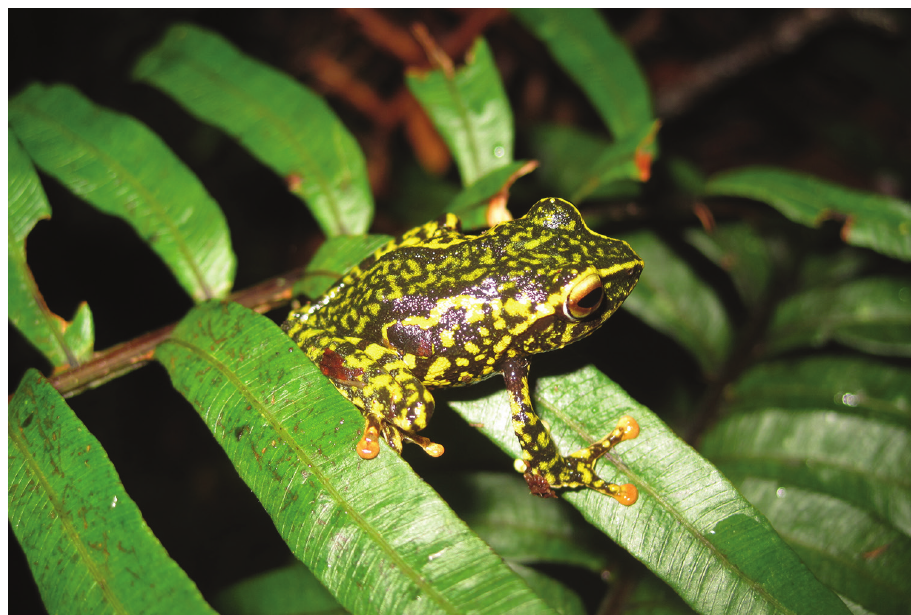
Figure 30. Philautus poecilus male from Mt. Lumot, Municipality of Gingoog, Misamis Oriental Prov- ince. Photo: